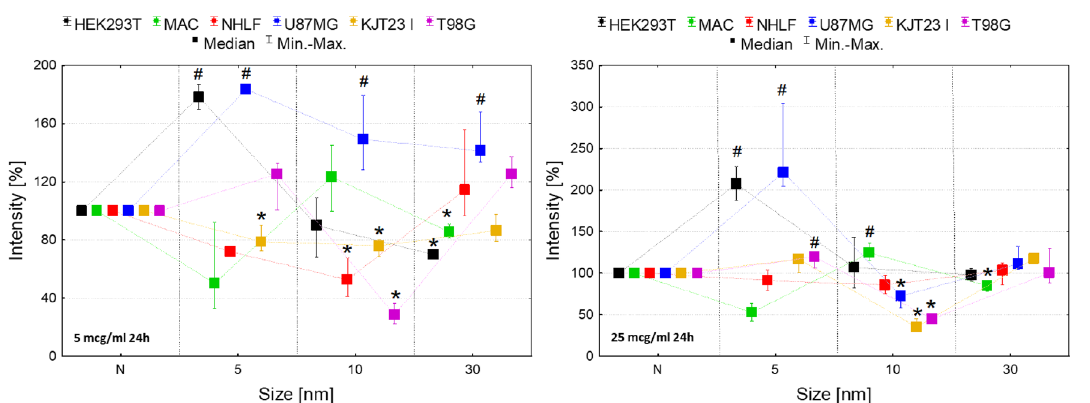
Figure 6. ROS levels after 24 h of exposure to IONPs having the diameters of 5 nm, 10 nm and 30 nm in the concentrations of 5 µg Fe/ml and 25 µg Fe/ml comparing to the control group (N). The statistically significant ( p < 0.05) increases in ROS level compared with corresponding N group were marked with “#” while decreases with